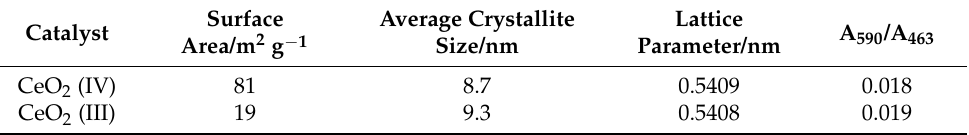
Table 1. Physiochemical properties of CeO 2 (IV) and CeO 2 (III) catalysts calcined at 500 °C for 3 h in static air.